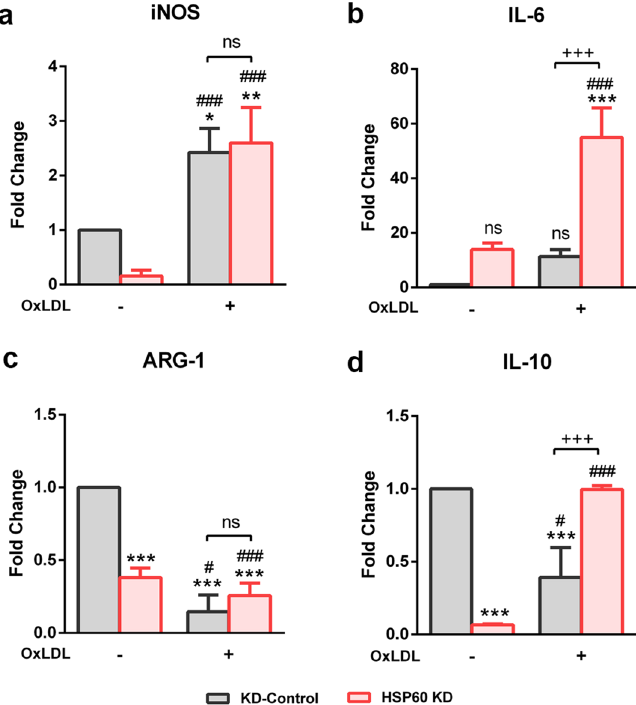
Figure 9. OxLDL induced polarization of HSP60 KD TDMs. OxLDL induced polarization events were checked by assessing the mRNA expression of M1 markers ( a ) iNOS and ( b ) IL-6 and M2 markers ( c ) ARG-1 and ( d ) IL-10 in OxLDL treated KD-Control and HSP60 KD TDMs. Data were expressed as Mean ± SEM (n = 3). *p < 0.05, **p < 0.01, ***p < 0.001 vs untreated KD-Control. ### p < 0.001 vs untreated HSP60 KD. + p < 0.05, +++ p < 0.001 KD-Control group vs HSP60 KD group, ns non-significant, Two-way ANOVA followed by Tukey’s multiple comparison